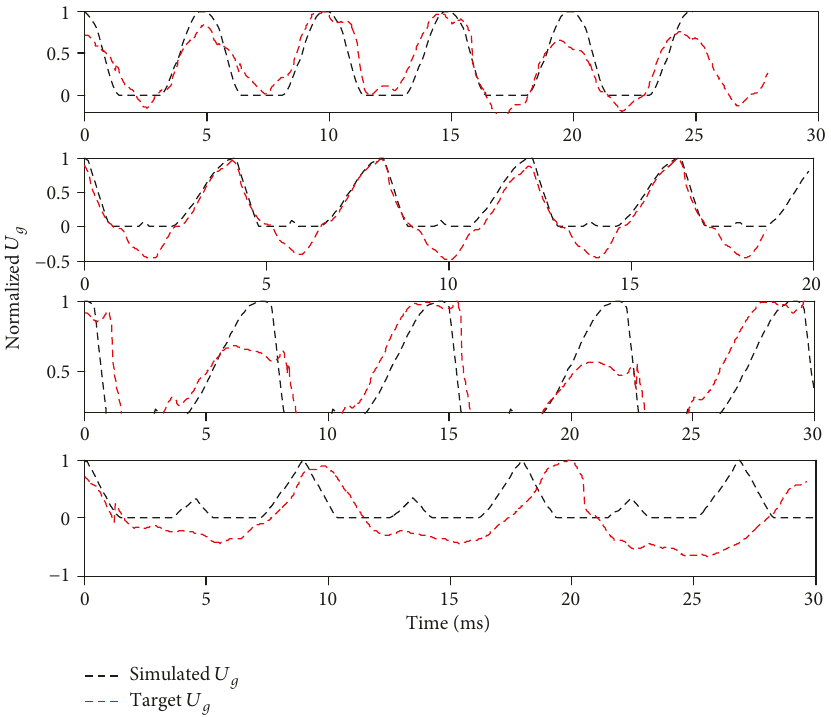
Figure 11: Matching result of paralysis voice source in the time domain.